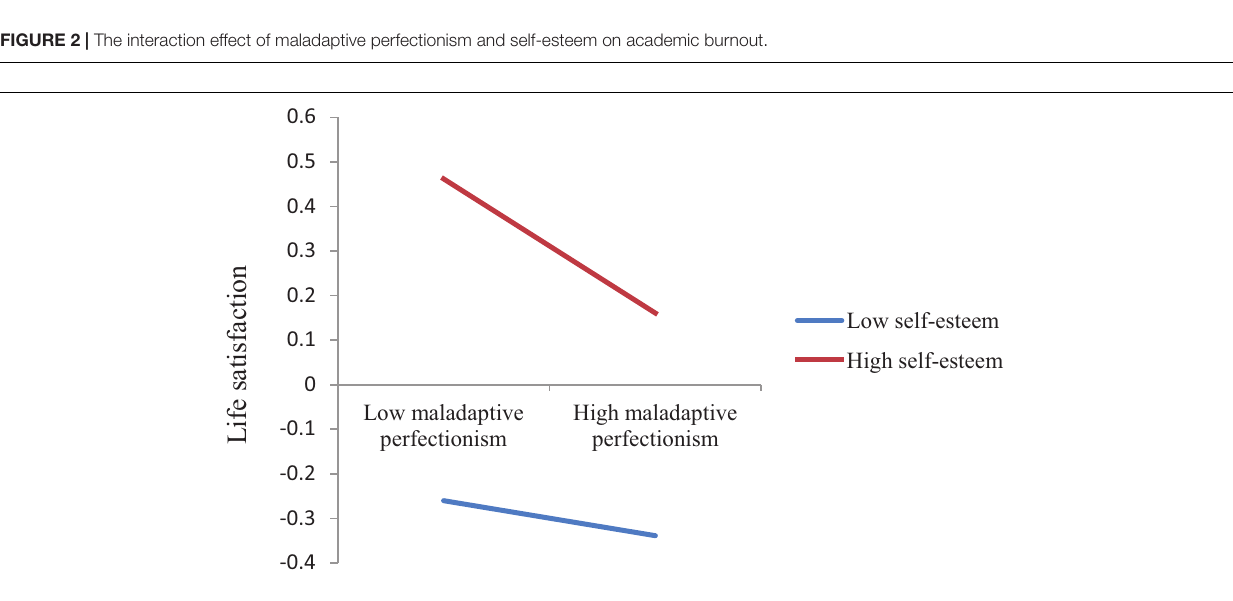
FIGURE 3 | The interaction effect of maladaptive perfectionism and self-esteem on life satisfaction.